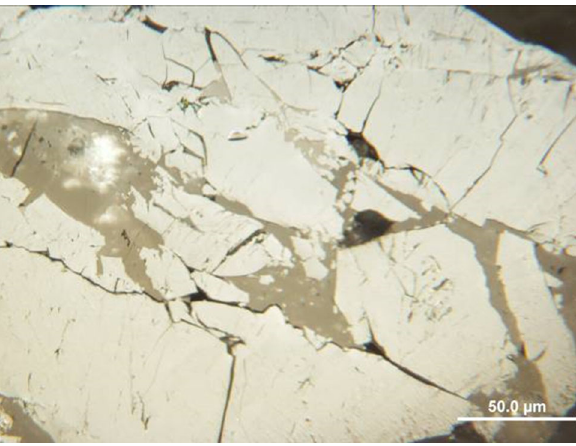
Fig. 11 Mylonite structure of low altered collotelinite ( R r above 0.75%)